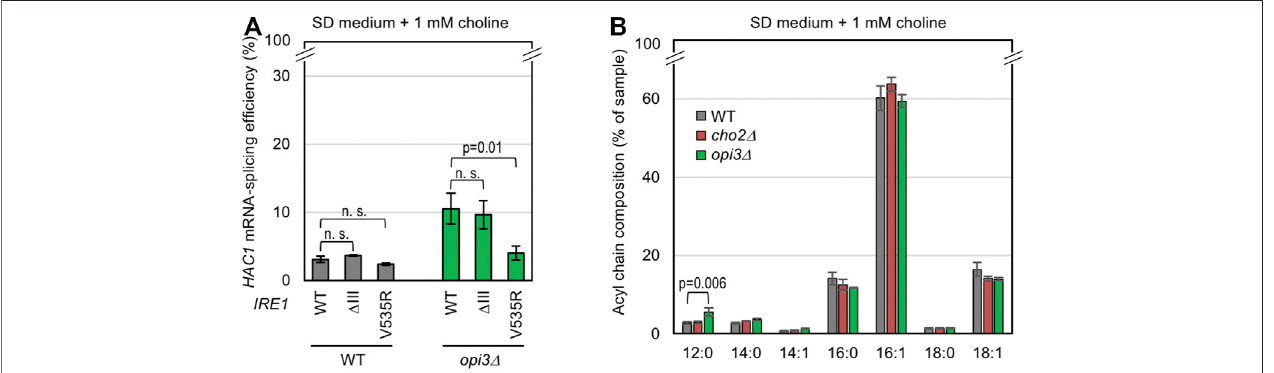
FIGURE 3 | Change in the membrane-lipid composition by PMME in yeast cells. (A) The KMY1516 strain ( ire1 Δ ) and its opi3 Δ mutant carrying the IRE1 plasmid pRS313-IRE1 (wild-type (WT) or the indicated mutants) were grown in SD medium containing 1 mM choline and were checked for HAC1 mRNA splicing. (B) Wild-type (WT) yeast strain BY4741 and its mutants were grown in SD medium containing1 mM choline and werechecked for their lipid fatty-acid composition. ns, not signi fi cant ( p > 0.05).